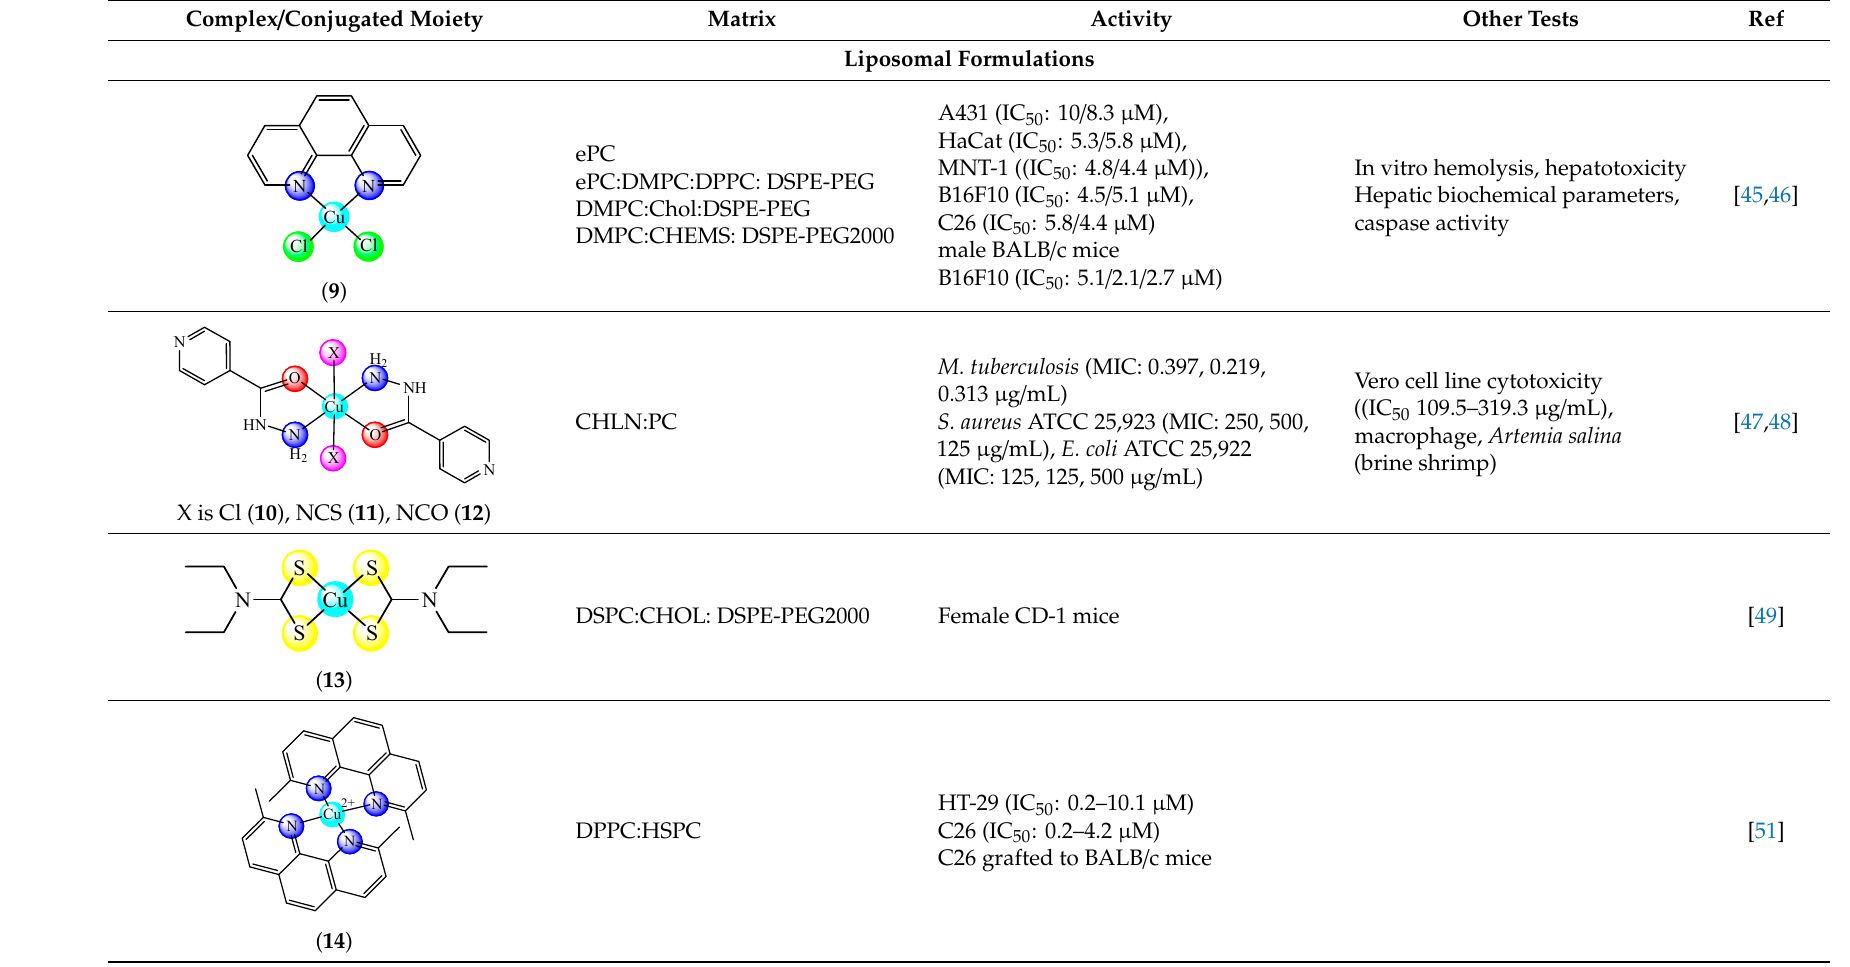
Table 1. Examples of biologically active Cu(II) complexes embedded in organic matrix.